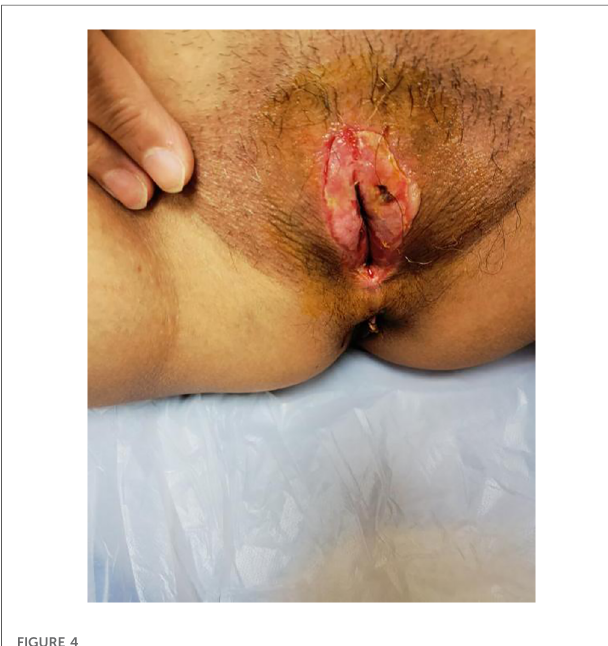
FIGURE 4 Healthy granulation tissue with a small amount of exudate.